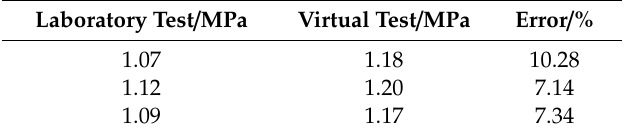
Table 5. Comparison of virtual and laboratory test results of the uniaxial penetration strength.